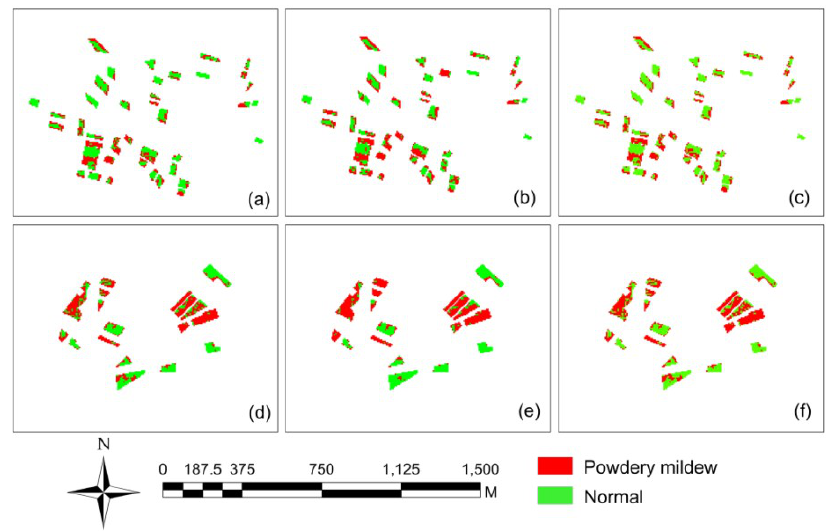
Figure 4. Infection maps of powdery mildew in a subset area produced by artificial neural network (ANN) ( a , d ), mahalanobis distance (MD) ( b , e ), maximum likelihood classifier (MLC) ( c , f ).